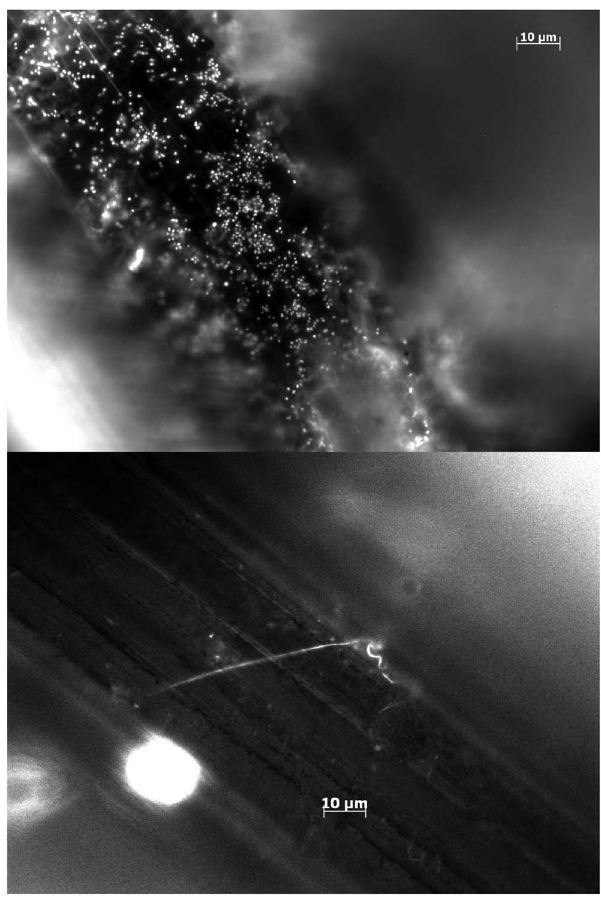
Figure 2. Biofilm assessment with epifluorescence microscopy. Figure 2A and 2B show biofilm formation by day 8 from two different samples. The biofilm formation is heterogenous from implant to implant. Implants are washed in saline and stained with DAPI. Biofilm formation by S. aureus exhibits intersample variation in both distribution and thickness, but was consistently found.